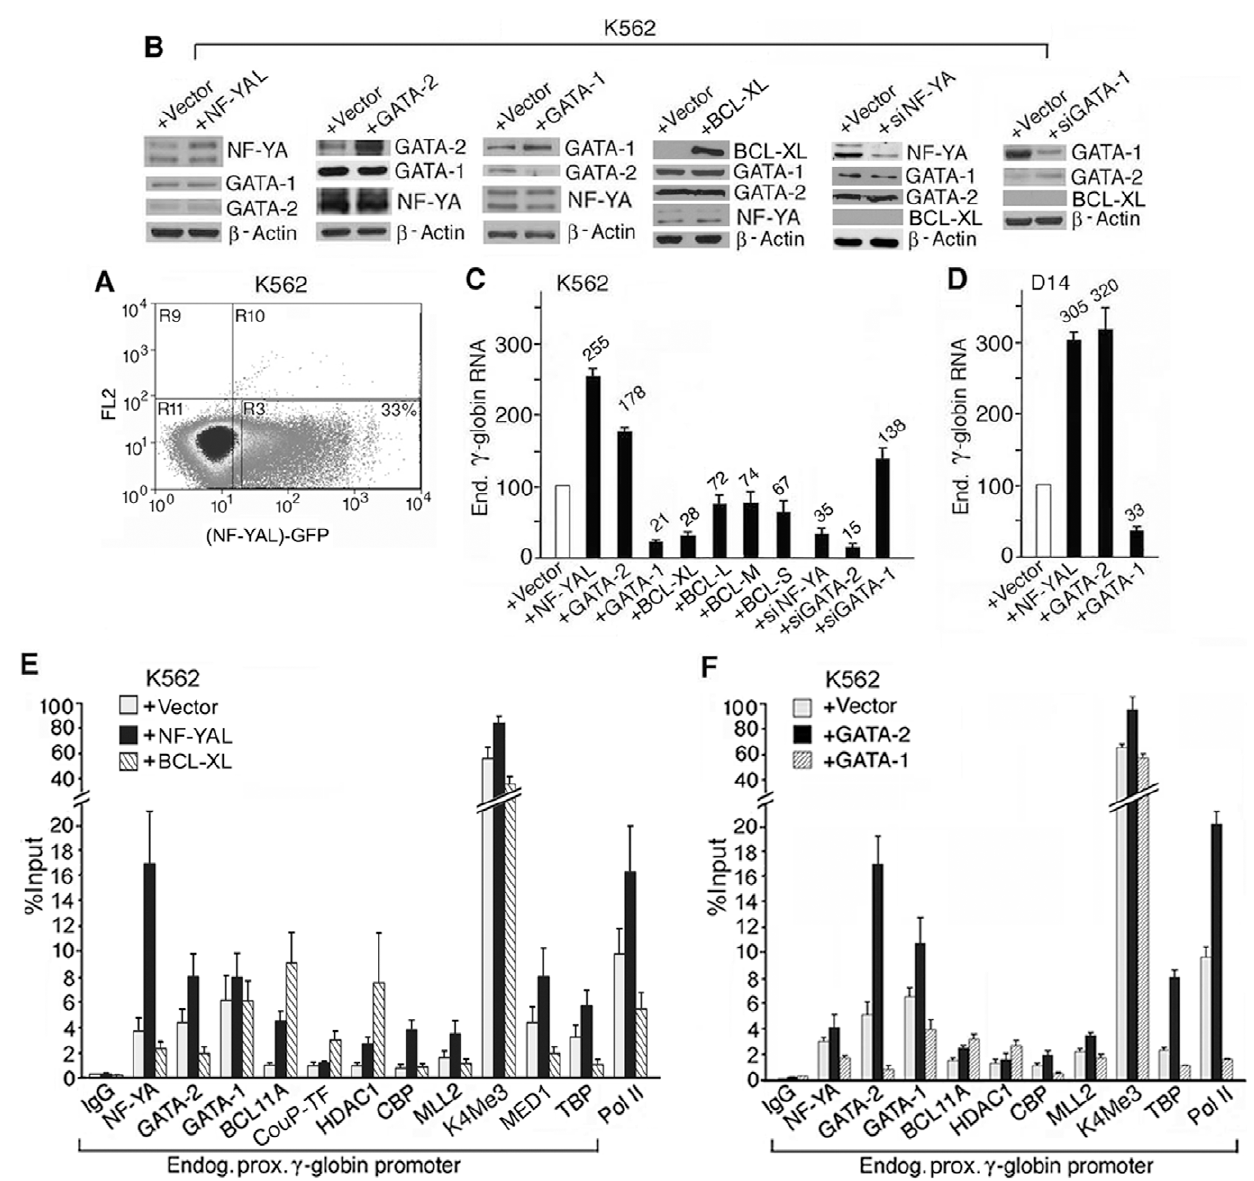
Figure 4. Over-expression of NF-YA, GATA-2, -1 or BCL11A activates or represses c -globin promoter activity and induces corresponding changes in the invivo assembly of proximal c -globin promoter complex. A. Fluorescent K562 cells over-expressing NF-YA long isoform (YAL) with co-expressed GFP sorted by FACS. Lower right quadrant: sorted GFP-fluorescent cells comprising 33% of total cell population used for analyses in panels B–E. FACS sorting of K562 and D14 cells over-expressing the other three transcription factors (not shown). B. Western blots of proteins isolated from K562 cells over-expressing NF-YAL, GATA-2, -1 or BCL-XL and K562 cells in which NF-YA or GATA-1 was knocked down by the respective siRNA, siNF-YA or siGATA-1. + Vector: control K562 cells trasduced or transfected by the empty vector. C & D. Effects of over- expression/knockdown of NF-YAL, GATA-2, -1 or various isoforms of BCL11A on the transcription level of endogenous c -globin mRNA in K562 and D14 adult erythroid cells determined by real-time RT-PCR. The level of c -globin mRNA in K562 and D14 cells transduced/transfected with the vector was set at 100. Levels of c -globin mRNA in test samples were averages of two independently transduced/transfected cells. Effects of over-expressing NF-YA short isoform, NF-YAS, on transcription of c -globin mRNA in K562 and D14 cells were similar to the effects of over-expressing NF-YAL (not shown). E & F . ChIP assays of the endogenous c -globin promoter in K562 cells over-expressing NF-YAL, BCL-XL, GATA-2 or -1. The NF-YA and BCL11A antibodies used in the ChIP assays recognized all isoforms of the respective transcription factor (Fig. 1C) and should pull down chromatin associated with all the isoforms of NF-YA and BCL11A. ChIP values were averages of two independent pull-down assays. doi:10.1371/journal.pone.0047175.g004 Over-expression of activator GATA-2 and repressor GATA-1 2 increased occupancy not only of GATA-2 but also of GATA-1 induced respective changes in occupancies of the transcription on the proximal c -globin promoter (Fig. 4F), even though GATA- activators, repressors, co-activators and co-repressors (Fig. 4F) 1 expression remained the same in cells over-expressing GATA-2 similar to the respective changes induced by over-expression of as in control cells (Fig. 4B, 2 nd panel from left). Thus, over- NF-Y and BCL11A (Fig. 4E). Notably, over-expression of GATA- expression of GATA-2 resulted in higher occupancy of not only